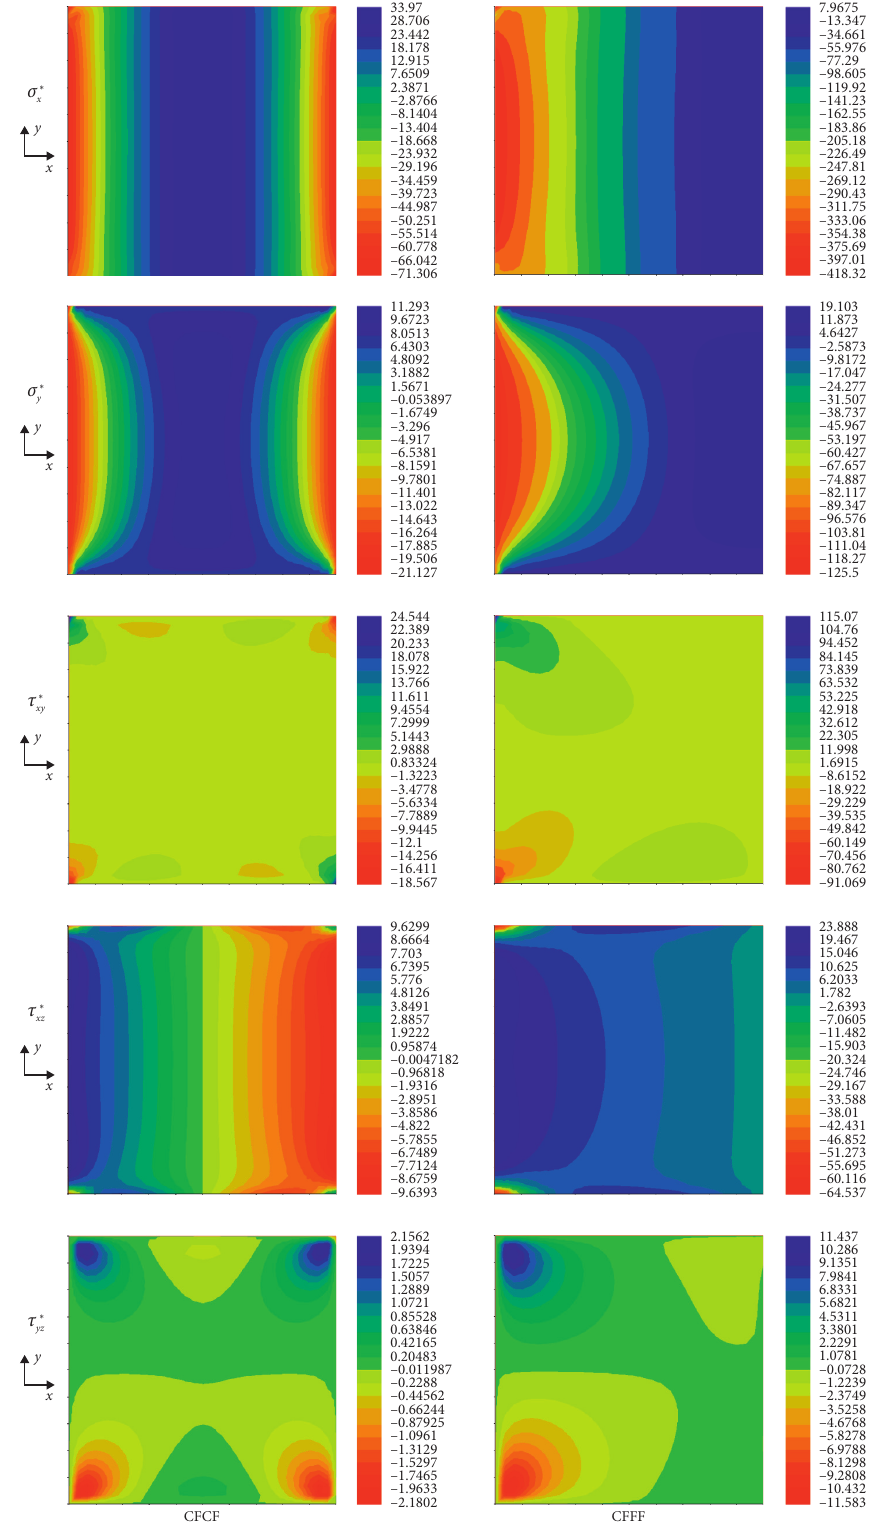
Figure 5: The stress distribution surface ( xy -plane) of FGM nanoplate subjected to uniformly distributed load q ψ �